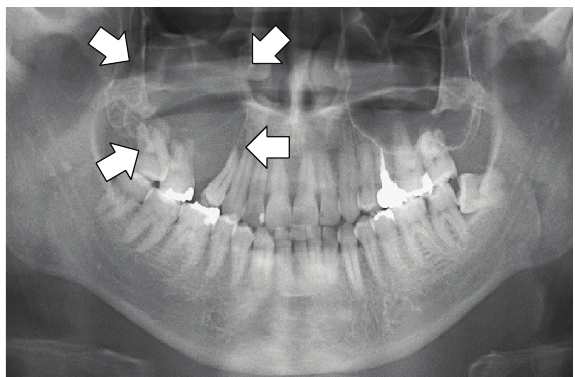
Figure 2: Panoramic radiography shows an osteolytic lesion in the right posterior maxilla with resorption of the floor of the maxillary sinus (arrows).